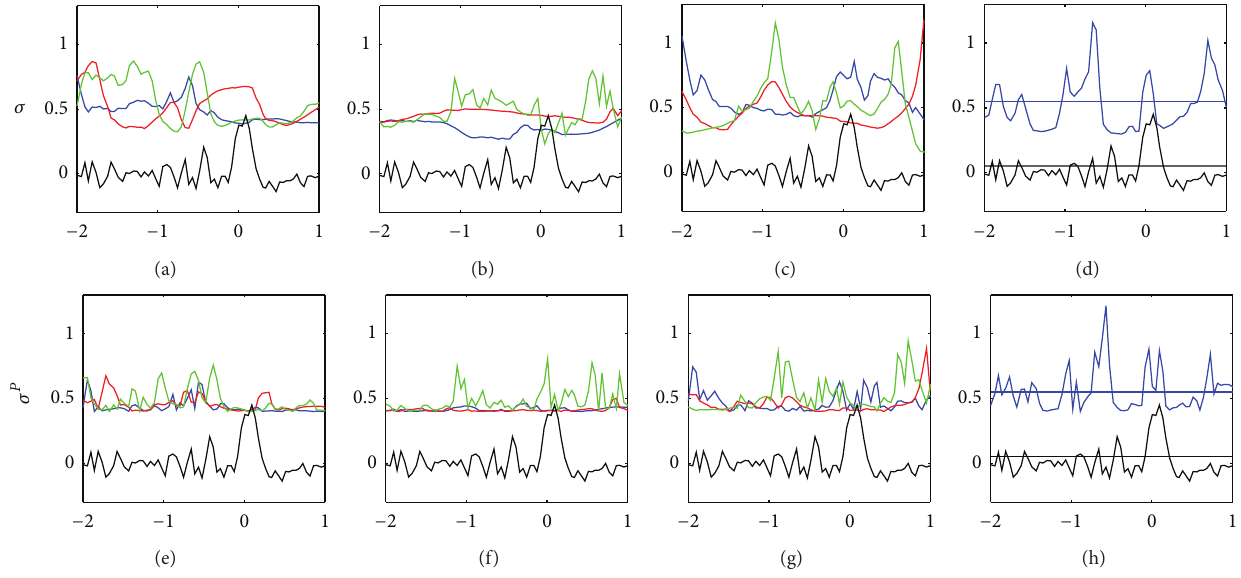
Figure 9: Lagrangian measures compared to vertical acceleration measured onboard an aircraft. From left to right, the data is from RAMS, FLOWSTAR, WRF, and LIDAR scans. Only backward time measures are compared since they are relevant to jolts experienced onboard. The top panels are the FTLE values interpolated along the glide path, and the bottom panels are the projected FTLE gradient. A strong windshear is reported at − 1NM from the runway threshold (0 in the 𝑥 -axis). The black curves in each panel are vertical acceleration measured from the aircraft. For the left three columns, the blue, red, and green curves correspond to data interpolated from the reduced FTLE, 2D FTLE, and LOS based FTLE. In the right column (from actual LIDAR), the blue curves are LOS based